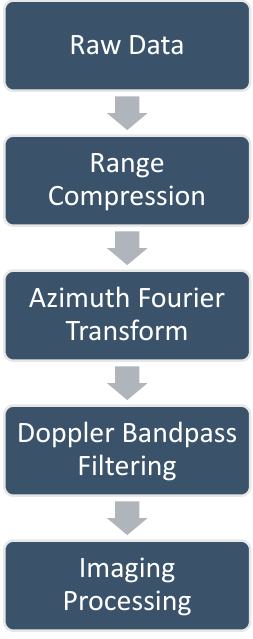
Figure 4. Processing flowchart of the OAM-based MIMO-SAR data.